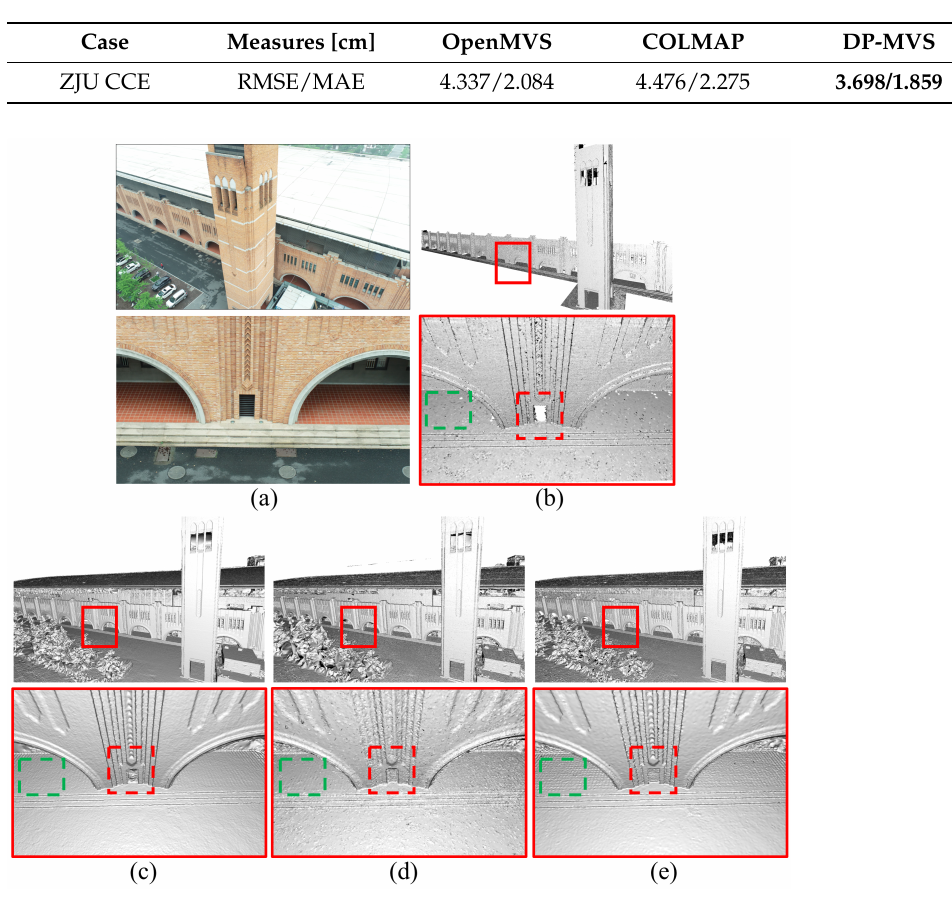
Figure 9. Comparison of our method with other SOTA methods on the case “ZJU CCE”, whose true 3D model is captured by a 3D laser scanner as GT. ( a ) Some representative source images. ( b ) The GT model captured by the 3D laser scanner. ( c ) The reconstructed surface model of Open- MVS [56]. ( d ) The reconstruction result of COLMAP [26]. ( e ) The reconstructed 3D model by our DP-MVS. Some detailed structures are highlighted in the rectangles to show the effectiveness of our reconstruction